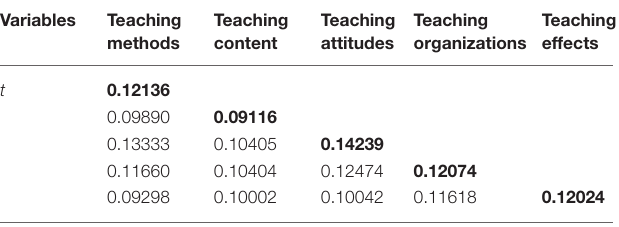
TABLE 5 | Variance components and covariance components from g study, effect of student numbers.